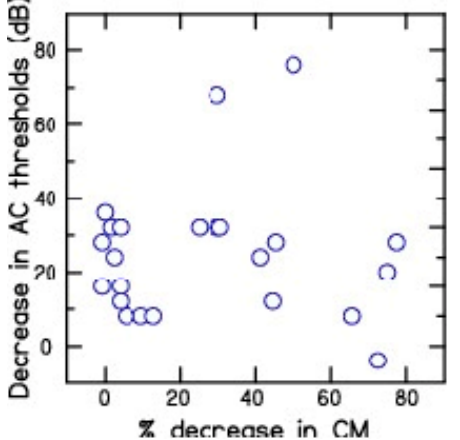
Figure 6. Comparison between percent decrease in CM (µV) amplitude and postoperative air-conduction thresholds (dB HL) across the frequency ranges of 250 to 800 Hz for the 10 cochlear implant patients.